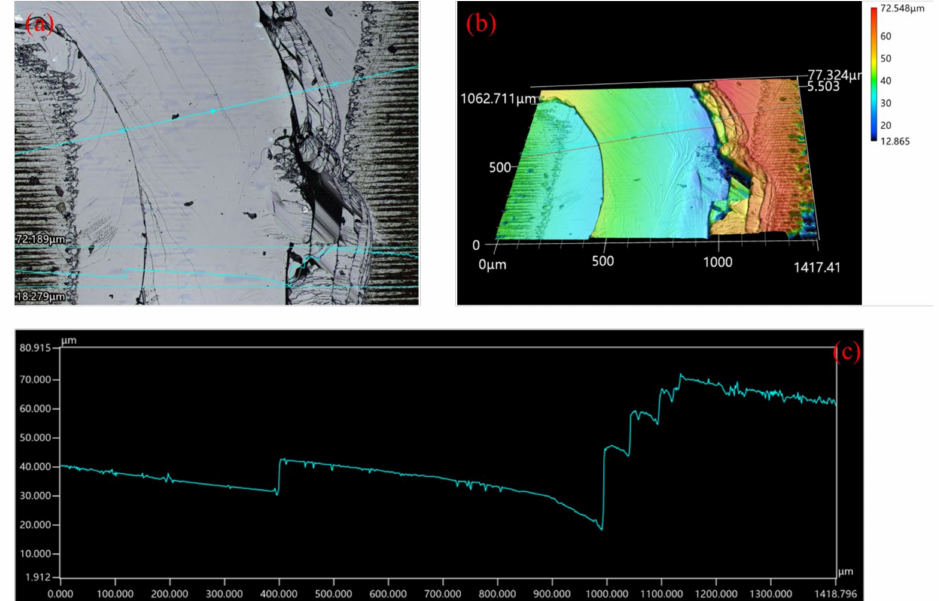
Figure 9. The observation by laser confocal microscope of sample 3. ( a ) Microscope view; ( b ) 3D view; ( c ) schematic diagram of step height difference.